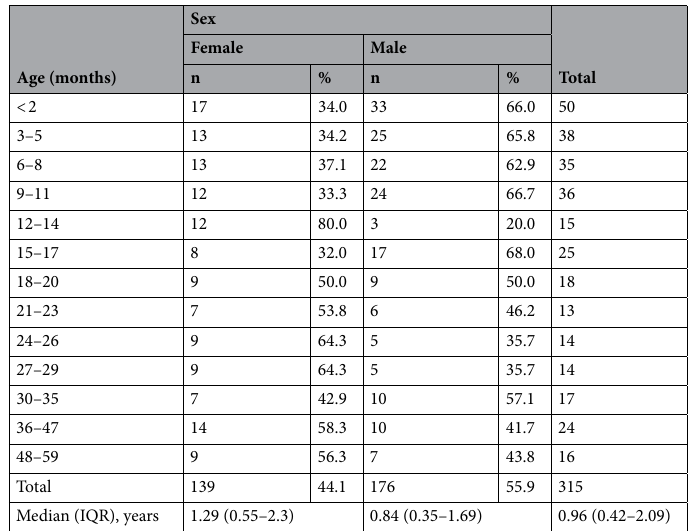
Table 1. Demographic characteristics of 315 children who were collected before the COVID-19 pandemic (2015–2018) in Biliran, Philippines. IQR interquartile